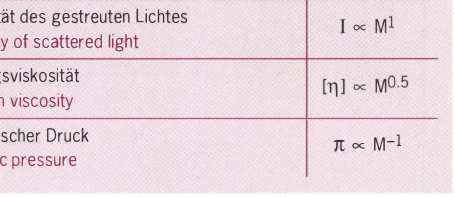
Tabelle 2: Fehler, L'.Mw, bei der